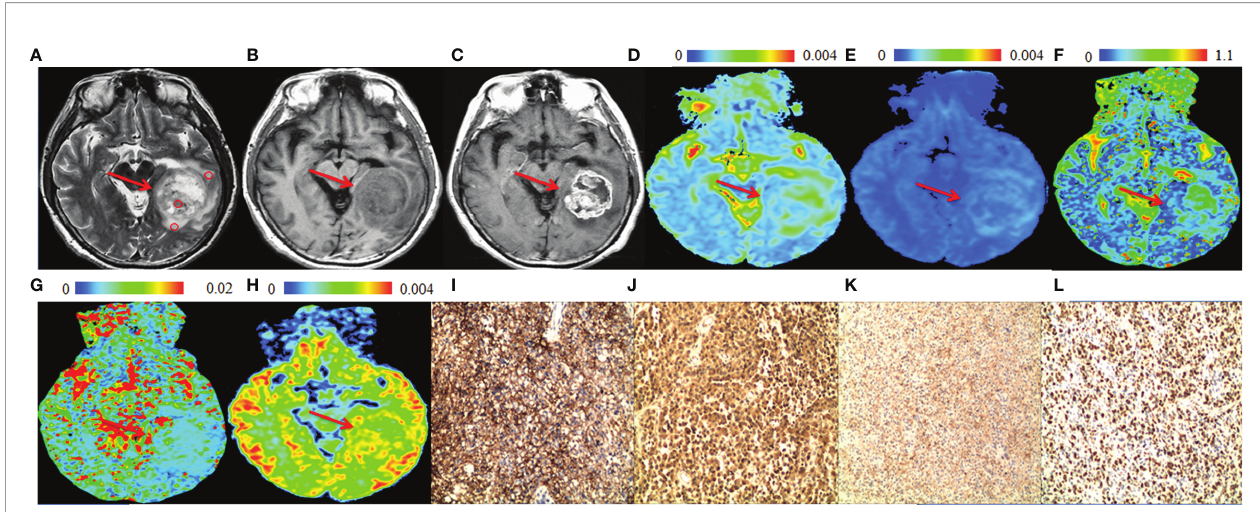
FIGURE 1 | A 57-year-old male patient with a representative glioblastoma (World Health Organization grade 4). In the solid part of the tumor (arrows), (A) T2- weighted image shows isointense to hyperintense (circles are the regions of interest), (B) T1-weighted image shows hypointense. (C) Post-gadolinium T1-weighted image shows enhancement of the solid part of the tumor. (D) apparent diffusion coef fi cient (ADC slow ) map and (E) slow diffusion coef fi cient (ADC slow ) map show no increase of the values in the solid part of the tumor. (F) fraction of fast diffusion component (F) map show no increase of the values in the solid part of the tumor. (G) pseudo-diffusion coef fi cient (ADC fast ) map shows increased values in the solid part of the tumor. (H) ADC with ultra-high b values (ADC uh ) map shows increased value in the solid part of the tumor. (I) aquaporin (AQP)1, (J) AQP4 and (K) Ki-67 immunohistostaining maps show increased expression, whereas (L) AQP9 immunohistostaining map shows no obvious increased expression (original magni fi cation,